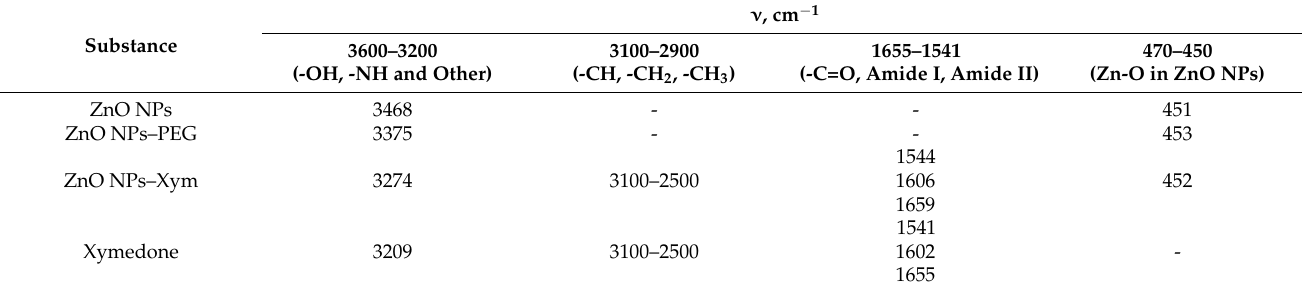
Table 2. Comparison of FTIR spectra data for studied samples.